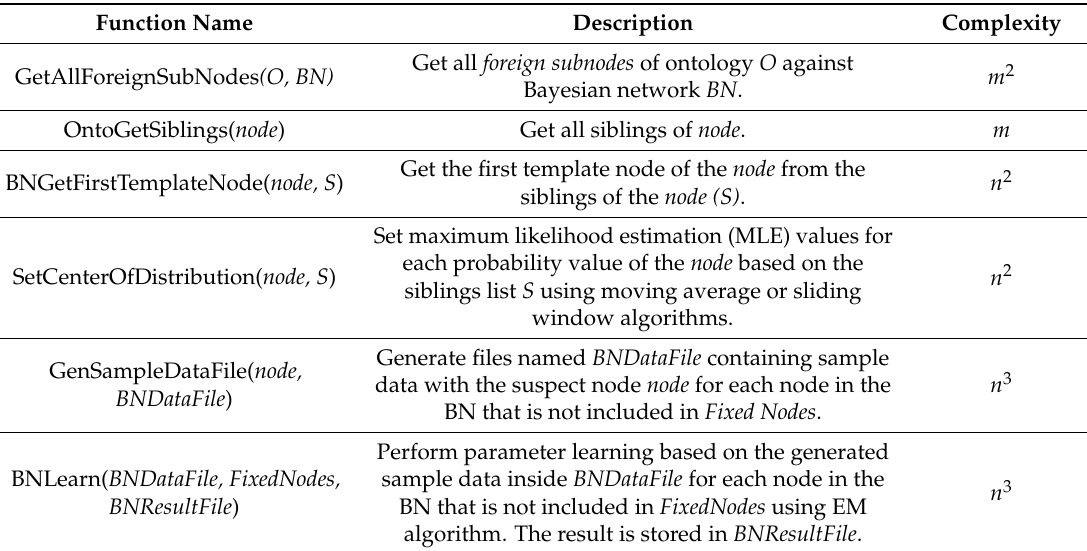
Table 3. Description of the functions used in the MergeOnto algorithm.